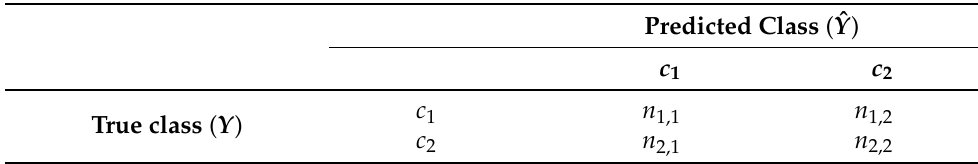
Table 1. A confusion matrix for two true classes Y ∈ { c 1 , c 2 } (in rows) and two predicted classes ˆ Y ∈ { c } (in 1 , c 2